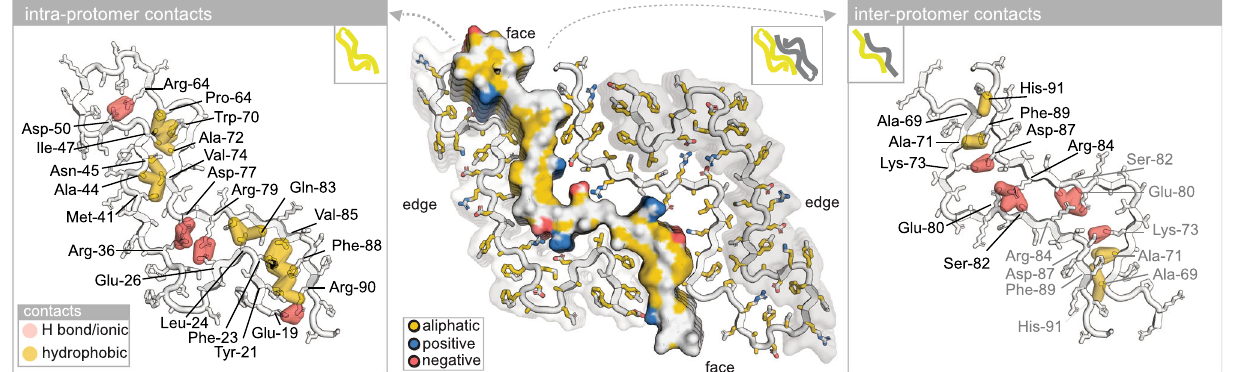
Fig. 3 | Staggered ionic locks and hydrophobic clusters stabilize intra- and inter-protomer interfaces. (Center)In the cross-sectional viewthe face of the left proto- fi lament is represented as molecular surface with aliphatic, positively and negatively charged side chain atoms in yellow, blue, and red, respectively. (Left, right) Sidechain contacts atthe intra- and inter-protomer interfaces are visualized inseparatepanelstotheleftandright,respectively.Hydrophobicandhydrogen(H)